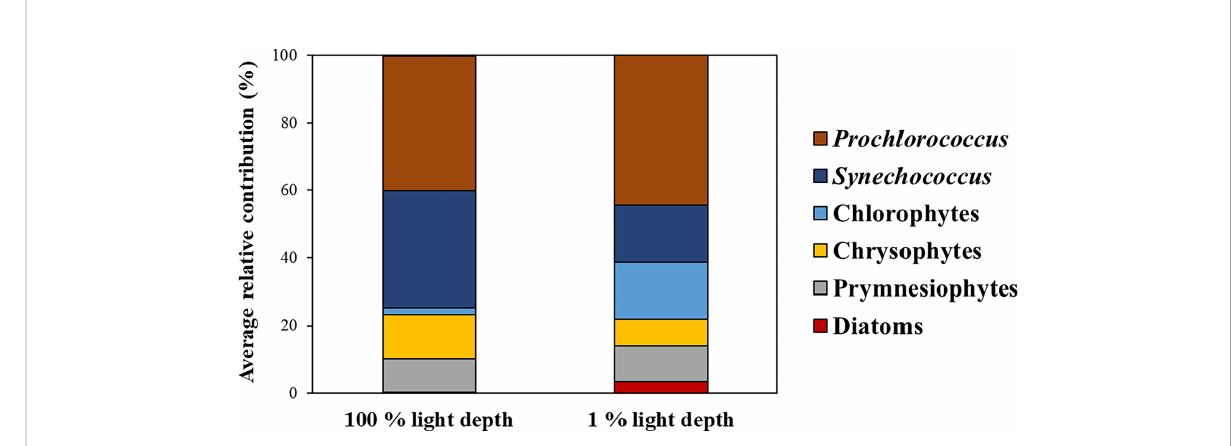
FIGURE 3 Average contributions of phytoplankton communities to total phytoplankton biomass between the two light